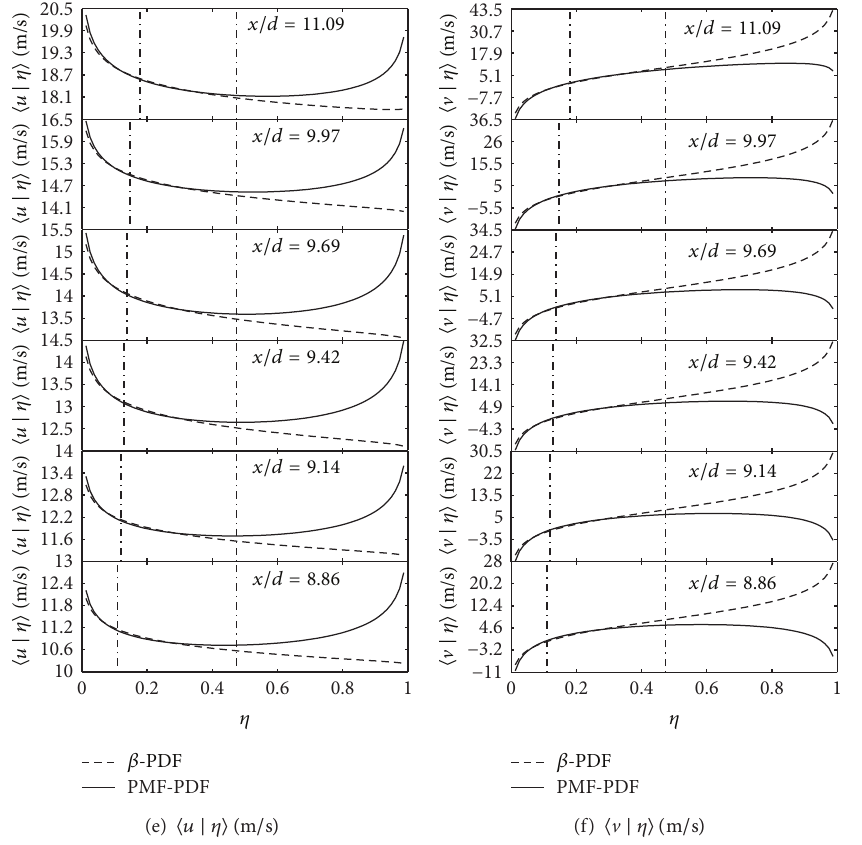
̃𝑃(𝜂) , (c) , (d) ⟨𝜒 | 𝜂⟩ (1/s), (e) ⟨𝑢 | 𝜂⟩ (m/s), and (f) ⟨ V | 𝜂⟩ (m/s) at 𝑦/𝑑 = 1 . 47 (the radial OH ̃𝜉 ). The thick st ̃𝜉 ). The coflow temperature is